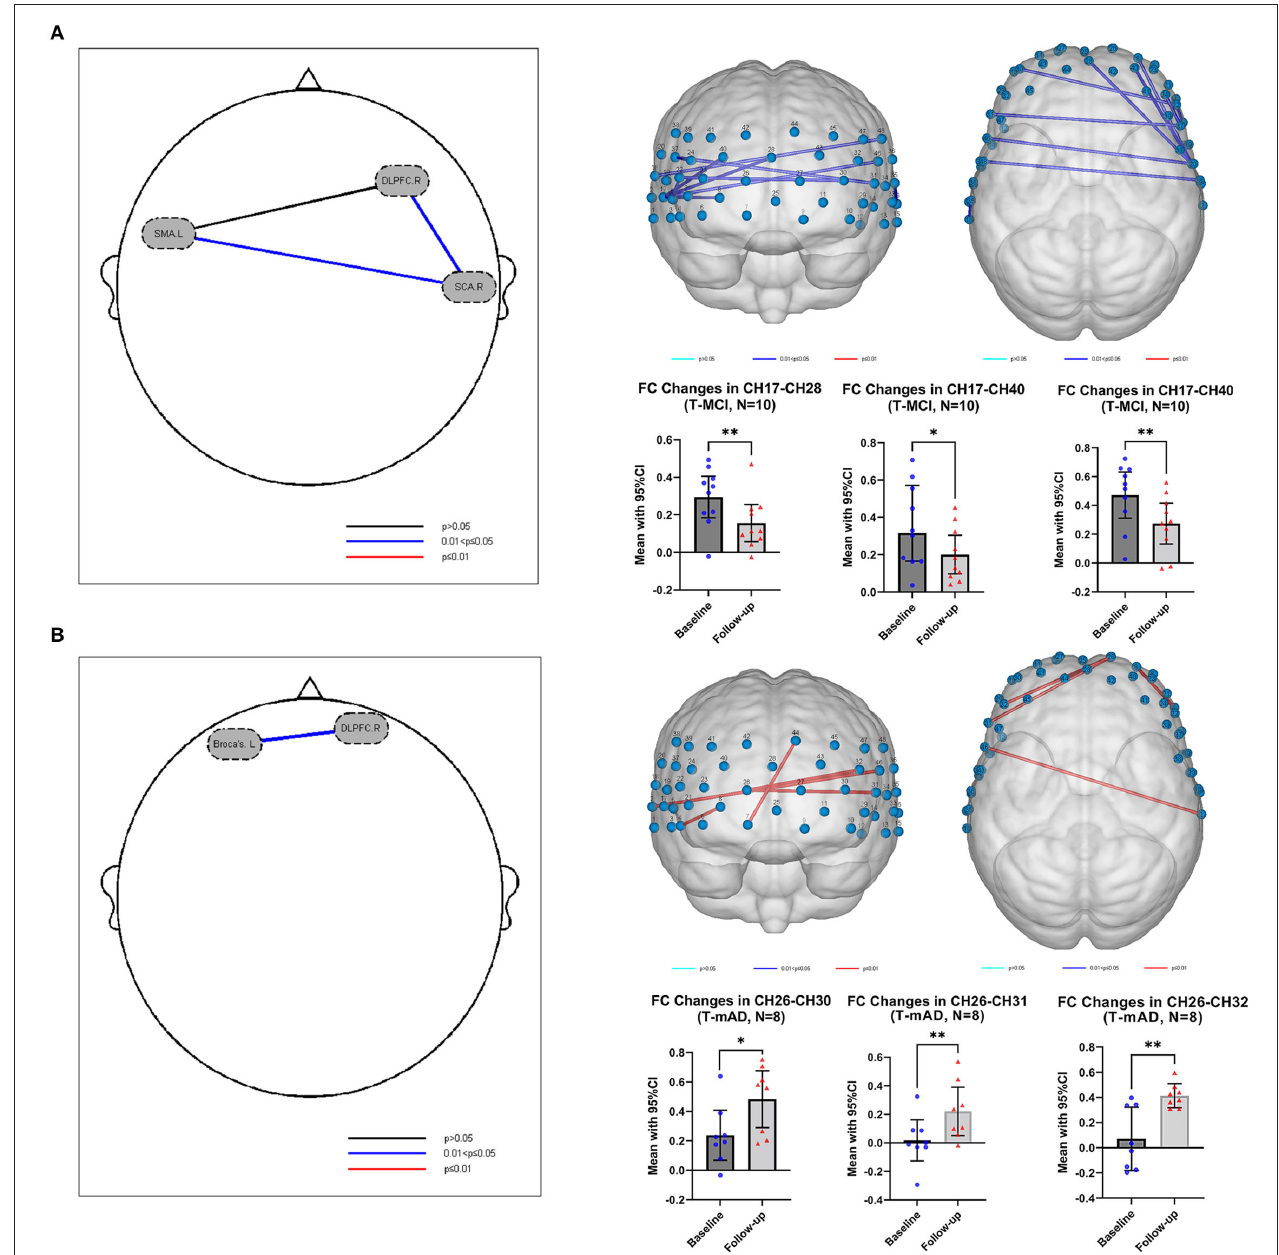
FIGURE 4 | Functional connectivity change after intervention. (A) The functional connectivity change in T-MCI ( n = 10) after sport stacking training for 12 weeks. (B) The functional connectivity change in T-mAD ( n = 8) after sport stacking training for 12 weeks. Each dot represents the FC value of each channel in T-MCI and T-mAD participants at baseline and at follow-up. * p < 0.05. No significant differences between intervention groups and control groups were found. ** p <